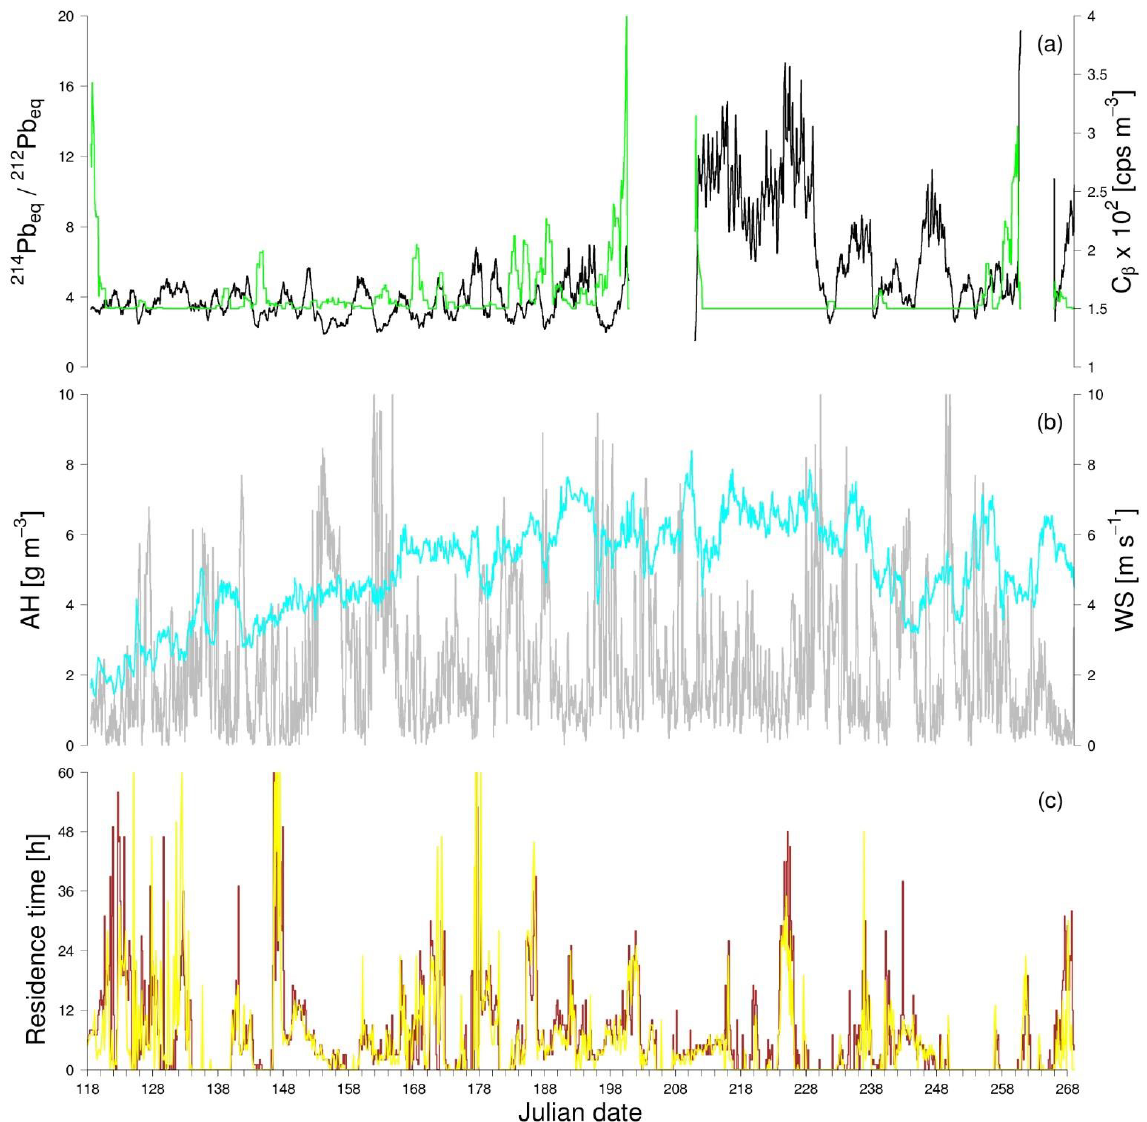
Figure 4. Evolution of the isotopic composition of radon progeny (a) compared with meteorological parameters (b) and the residence time of air masses close to Svalbard islands (c) . The 214 Pb eq / 212 Pb eq ratio (black) is reported with the relative counts of C β (green). The wind speed (grey) and the absolute humidity (cyan) are associated with the residence time of air masses over Svalbard (within a distance of 350km) at different altitudes: 500ma.s.l. (red) and 1000ma.s.l.